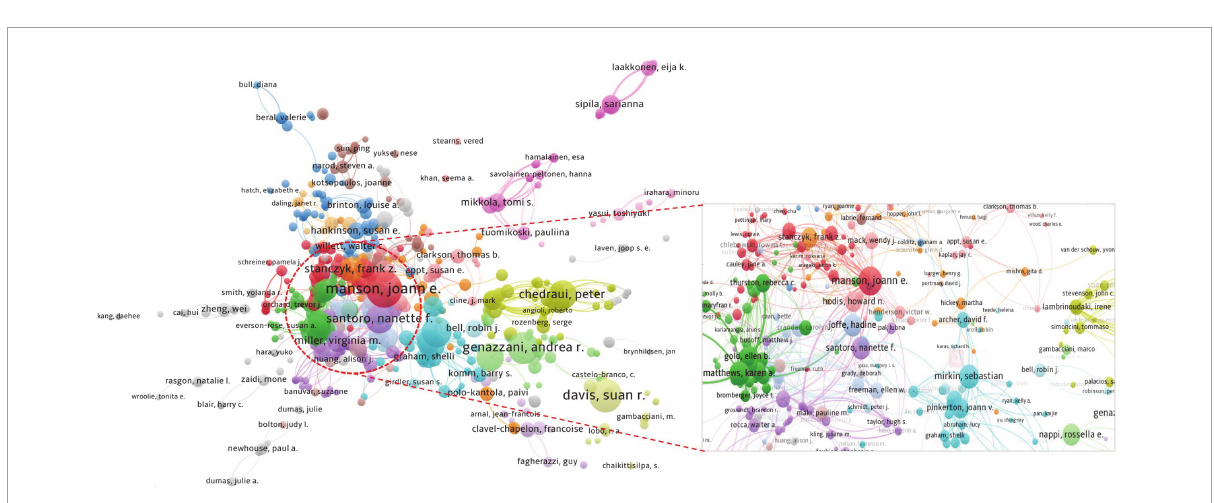
FIGURE6 Co-authorship network of menopausal hormone therapy (MHT)-related